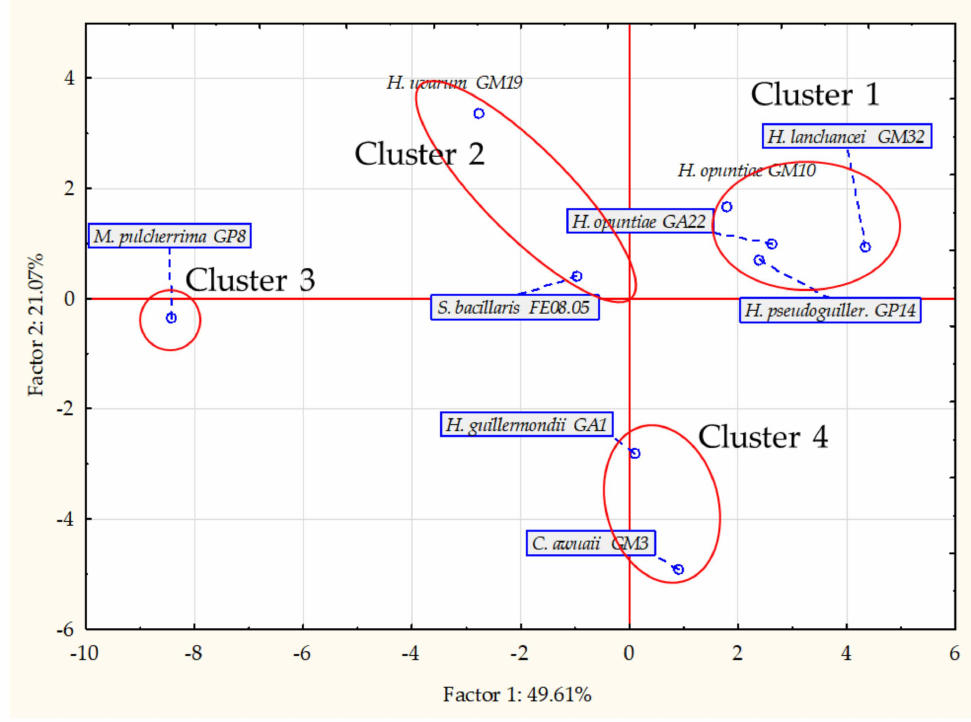
Figure 6. Principal component analysis loading plot of volatile organic compounds (VOCs) of the selected yeast strains with antifungal properties after 6-days of growth in malt extract broth at 25 ◦